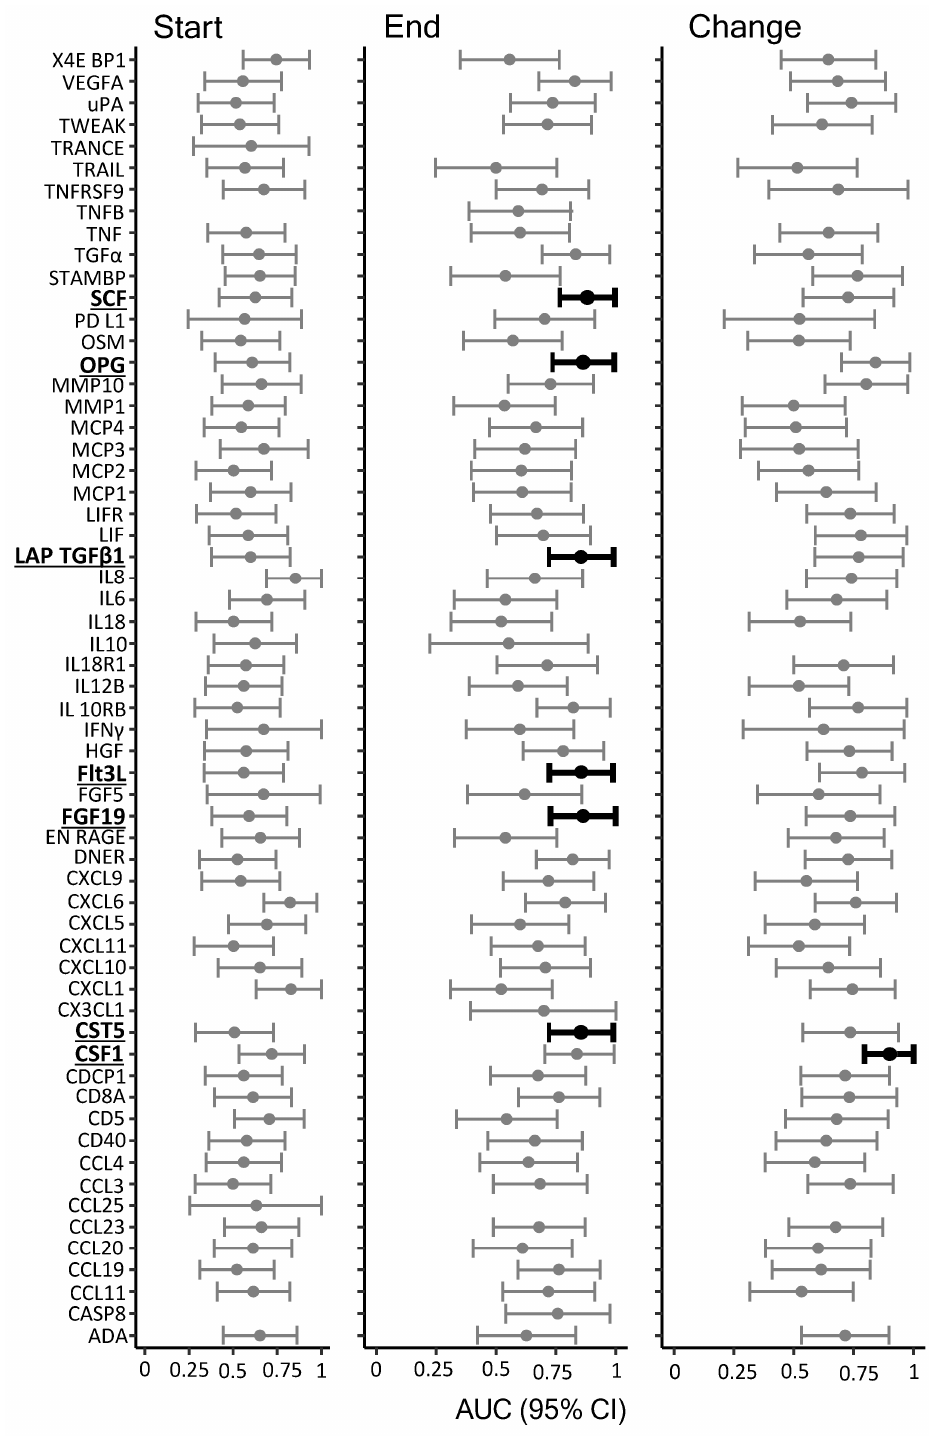
Figure 1. Inflammatory markers as predictors of shunt dependency. The figure illustrates AUC and 95% CI for prediction of shunt dependency for each of the detected inflammatory markers. The markers (highlighted/black bars) that reached the required level of ≥ 0.7 of the lower confidence limit were accepted as prognostic markers of development of hydrocephalus following SAH. EVD weaned: n = 19; VP-shunt. n = 12; AUC: area under the curve; CI: confidence interval.